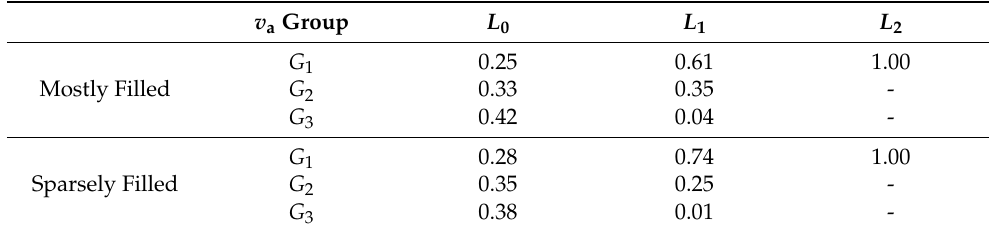
Table 3. Comparisons of Π A , L 0 , L 1 , and L 2 between the proposed CNN and the conventional region- based methods. Both methods perform equally well under conditions with mostly filled precipitation. However, under conditions with sparsely filled precipitation, the CNN model outperforms the region-based method. Π A (%) L 0 (%) L 1 (%) L 2 (%) CNN 99.58 99.62 97.89 93.44 Mostly Filled Region-Based 99.90 99.87 98.54 94.30 Difference − 0.32 84.96 Sparsely Filled Region-Based 96.39 96.88 91.45 74.39 Difference 2.84 1.51 10.57 Table 4. Evaluation weights of the different v a groups and label sets used in Equation (10). The weight is the inverse of the population ratio of each group. As expected, the sum of the weights within each label set is always equal to one. v a Group L 0 L 1 L 2 G 1 0.25 1.00 Mostly Filled G 2 0.33 G 3 G 1 0.28 0.74 1.00 Sparsely Filled G 2 0.35 0.25 - G 3 0.38 0.01